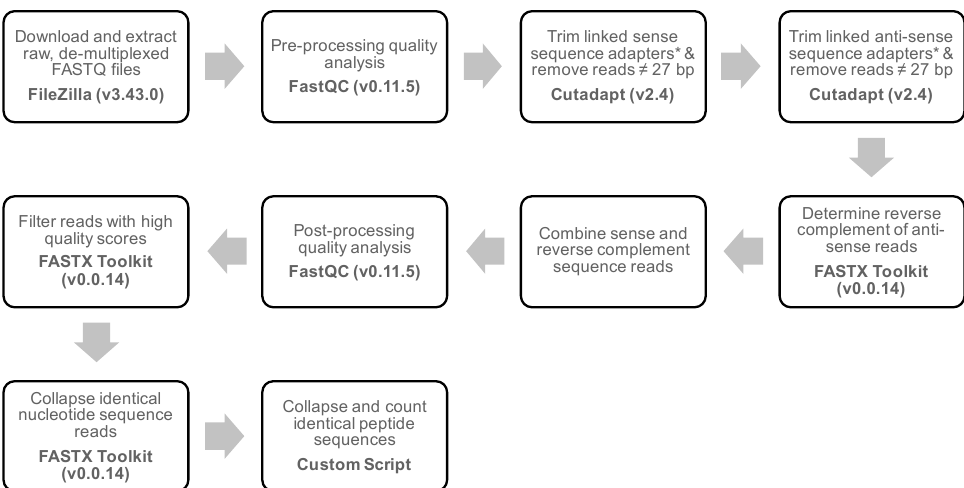
gp8-Targeted next-generation sequencing bioinformatics workflow. Schematic for identificationofdisplayedpeptidesequencesfromlandscape(type-8)phagelibrariesvianext-generation sequencing. Briefly, raw nucleotide sequence reads are trimmed for linked sense / anti-sense upstream and downstream regions of gp8 and filtered based on the expected nucleotide insert size. High quality indicating number of nucleotide variants encoding each